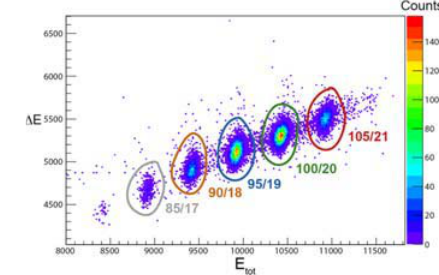
Figure 1. Scheme of the LOHENGRIN spectrometer (left). Plot of the energy loss Δ E in the first part of the IC and the total energy loss E tot inside the IC. Each spot corresponds to a kinetic energy, which refers to the fission product mass (right). The mentionned numbers correspond to the ratio A /